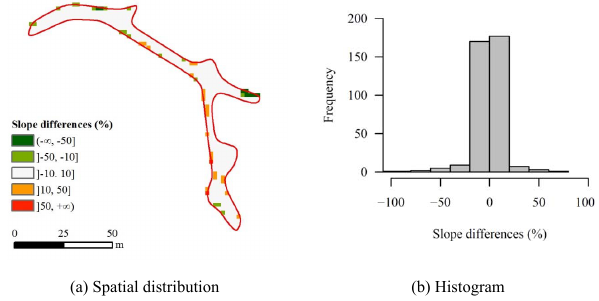
Figure 9. Slope differences between the UAV DEM and the lidar